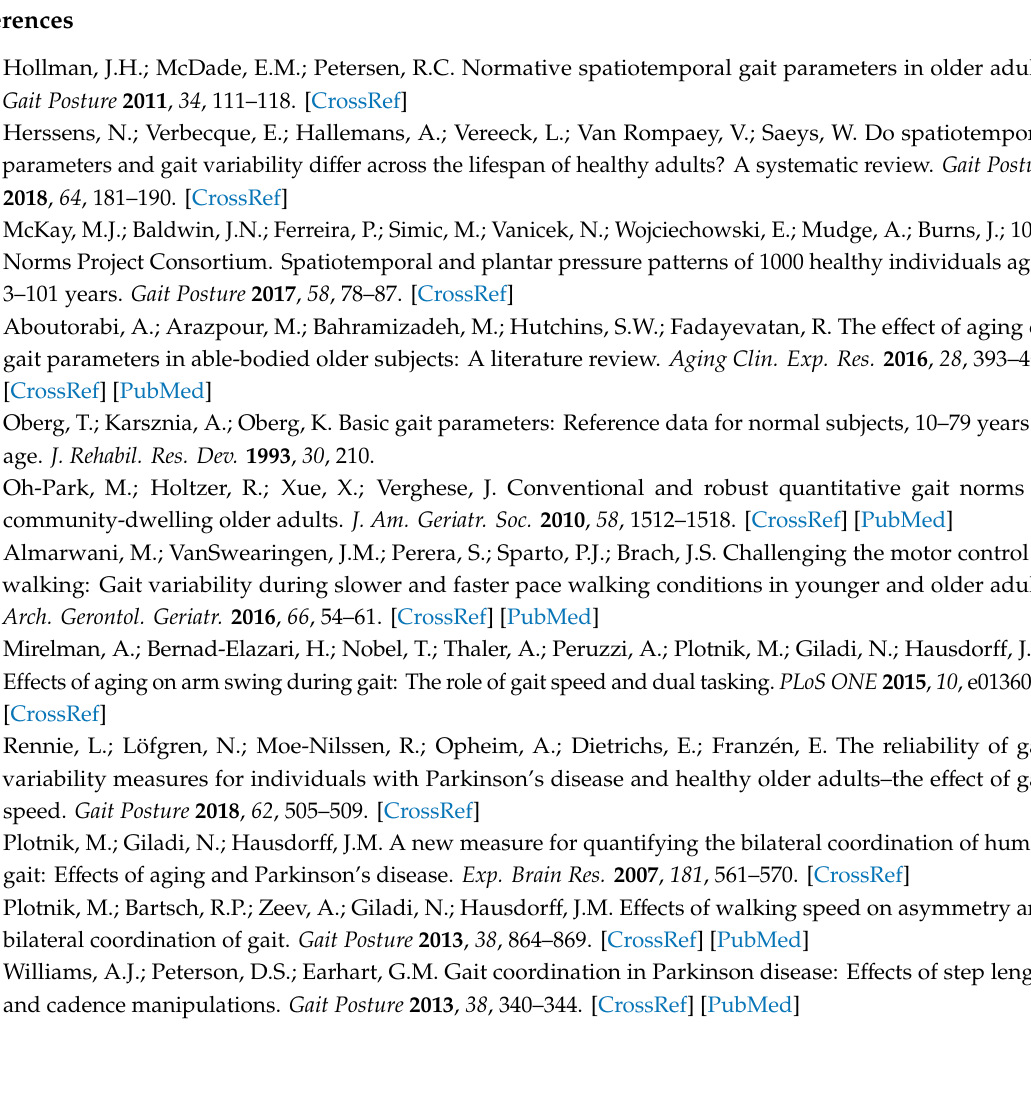
Table S1. Association of physical activity with GV and bilateral coordination. Supplementary Materials 1: IRB number. Supplementary Materials 2: Raw